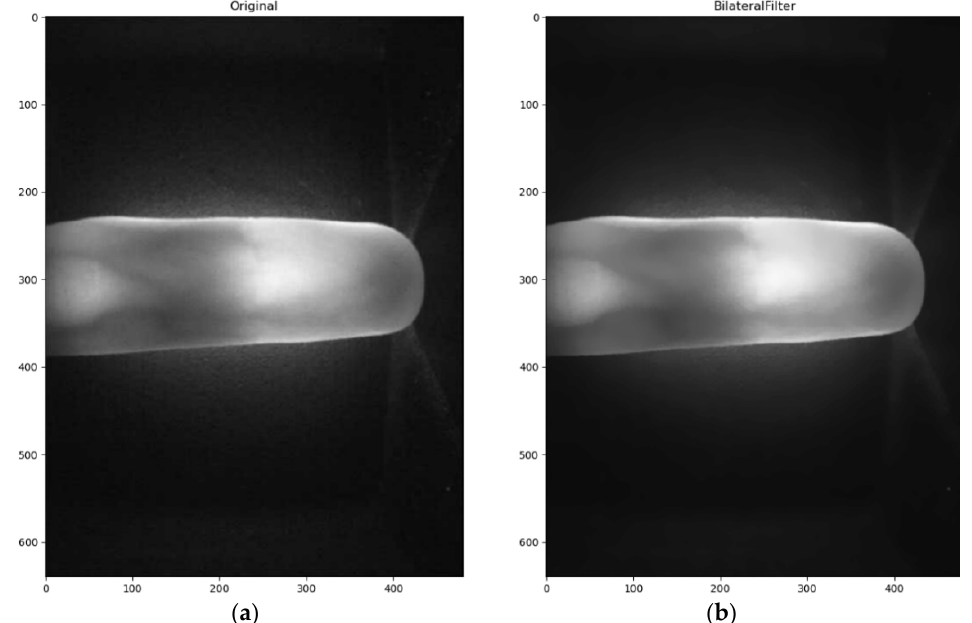
Figure 2. Bilateral filter processing for a finger ‐ vein image: ( a ) Without the filter; ( b ) With the filter.